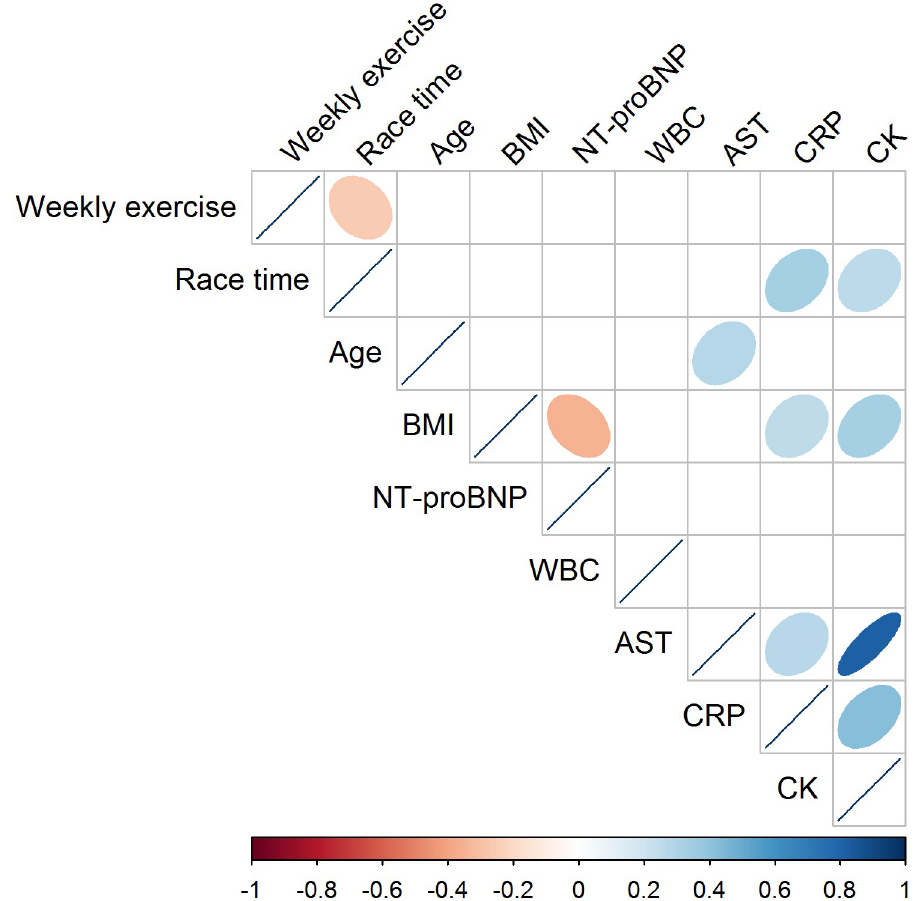
Fig 1. Correlations. Correlation matrix with Spearman correlations between the clinically significant elevations in blood samples: NT-proBNP, white blood cells (WBC) and Creatinine Kinase (CK) measured after finish; Aspartate Aminotransferase (AST) and C-reactive protein (CRP) measured the following day; reported weekly exercise; race time; age; and BMI. The correlation coefficient is visualised by gradient colour and shape to indicate negative correlation (red) and positive correlation (blue). Non-significant results are blank with the significance level set to p < 0.05.